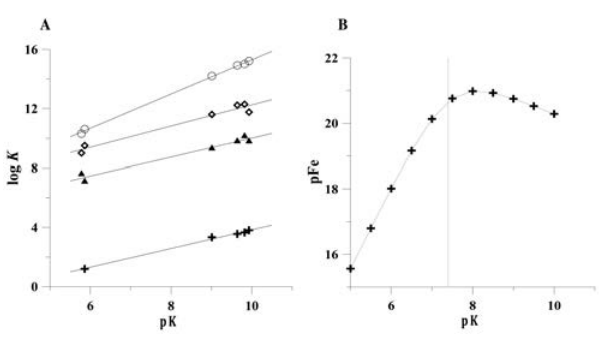
Figure 2. A) The formation constants log K ( ° ), log K ( Ø ) 11 12 and log K ( ) (relative to the complexes FeL, FeL and FeL , 13 2 3 ▲ formed between iron III and the pyridinones in Table 1) and the second protonation constant log K (  ) are reported vs the first 2 protonation constant log K . B) pFe calculated from the set of 1 constants obtained as a function of log K . (Reprinted from 1 Coordination Chemistry Reviews, Vol 252, Crisponi G., Remelli M., Iron chelating agents for the treatment of iron overload, Pages No. 1225–1240, Copyright (2008), with permission from